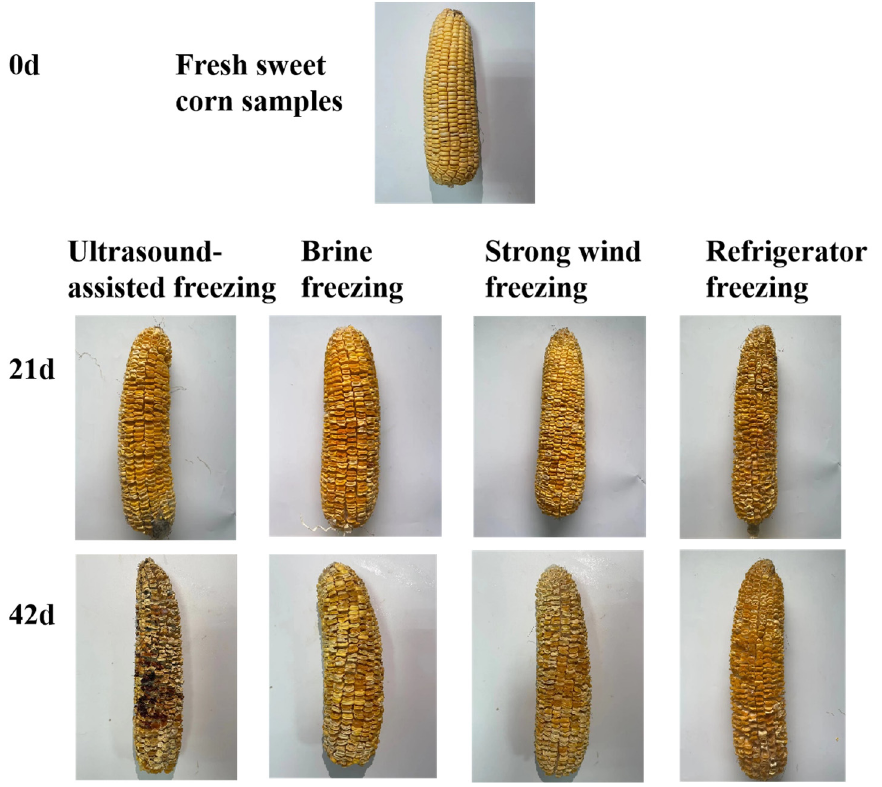
Figure 1. The appearance changes of sweet corn during storage with four different freezing methods.